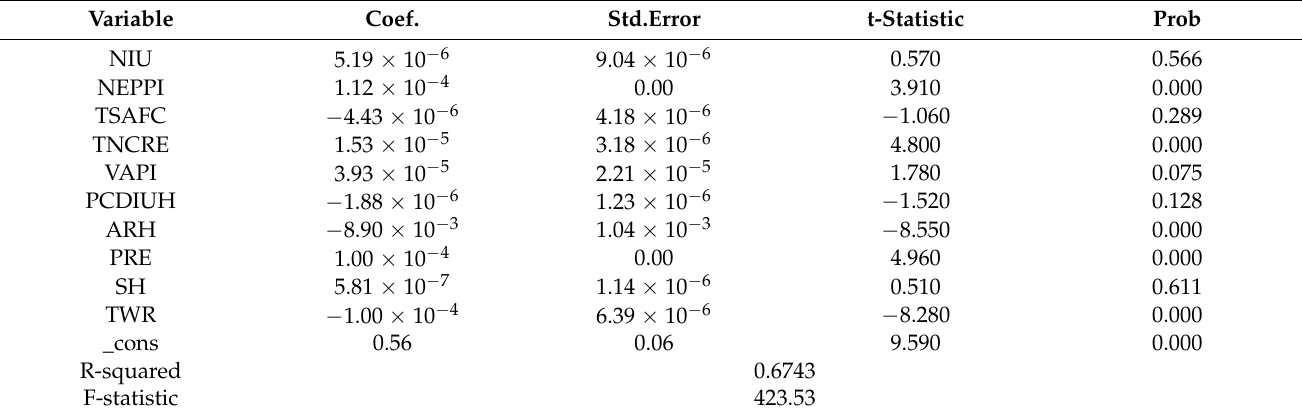
Table 10. GMM regression analysis.